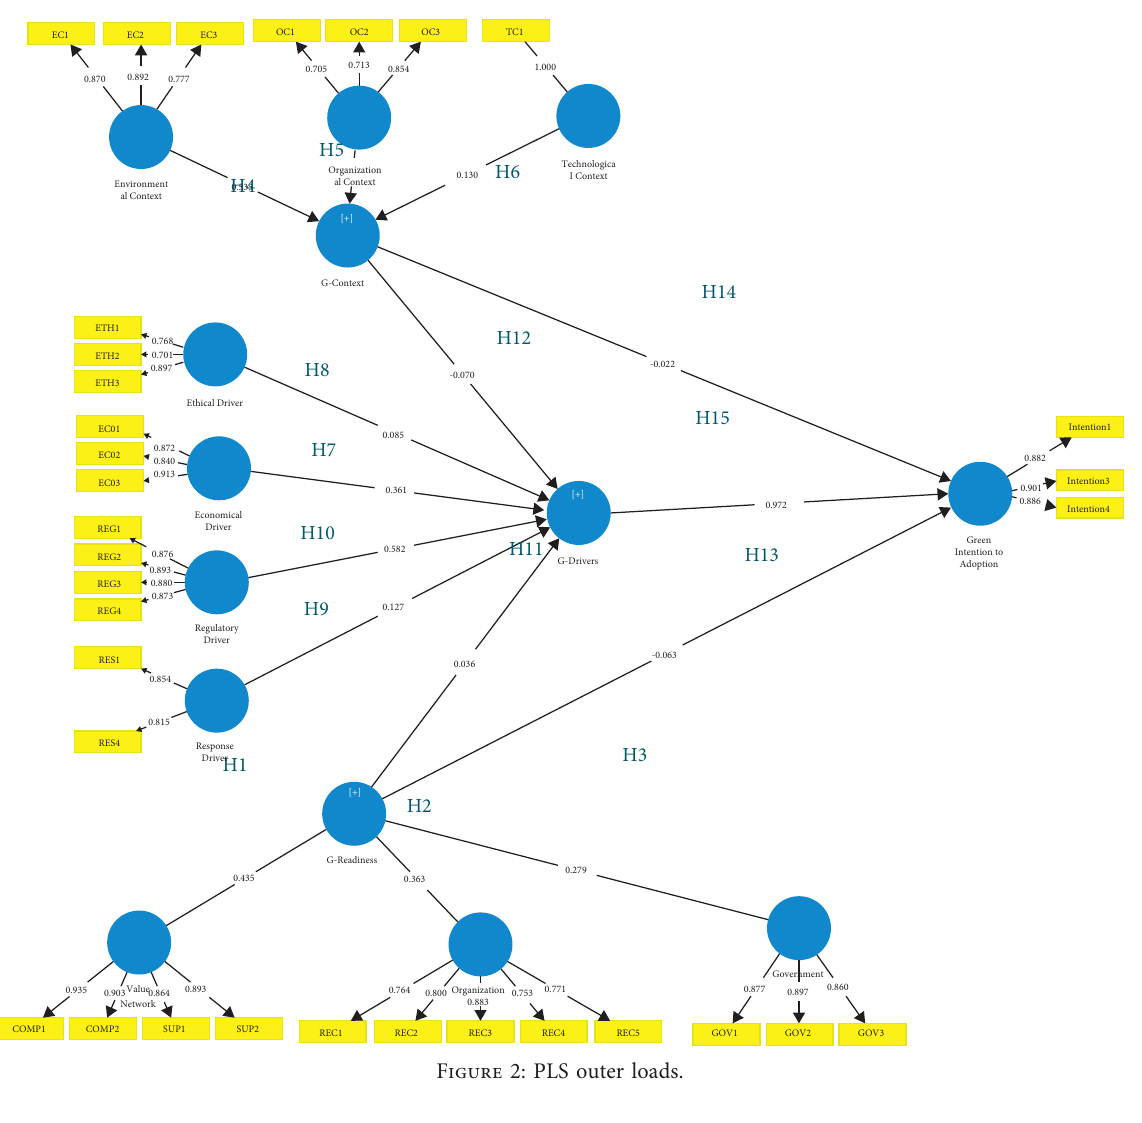
Figure 2: PLS outer loads.